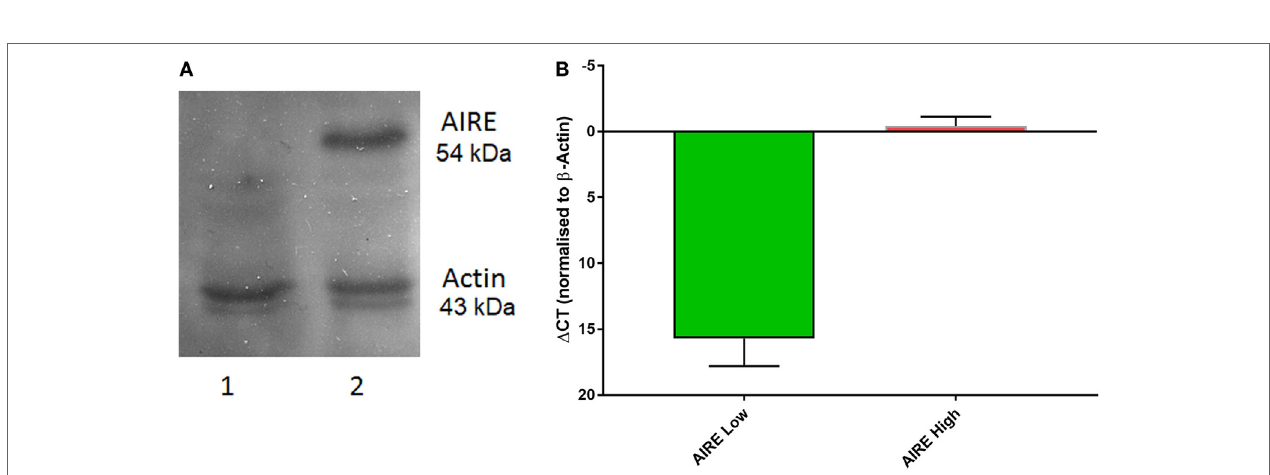
FigUre 2 | Autoimmune regulator (AIRE) expression in TEC 1A3. (a) Western blot of protein lysates from TEC 1A3 flp-in host cell line (lane 1) and TEC 1A3 recombinant AIRE overexpression cell line (lane 2). (B) QPCR determined relative expression levels of AIRE ( γ Ct) after normalization against beta-actin in AIRE-low cells (1; green) and AIRE-high cells (10; red). Y -axis was switched to inverse ( γ Ct) so that values go upwards.